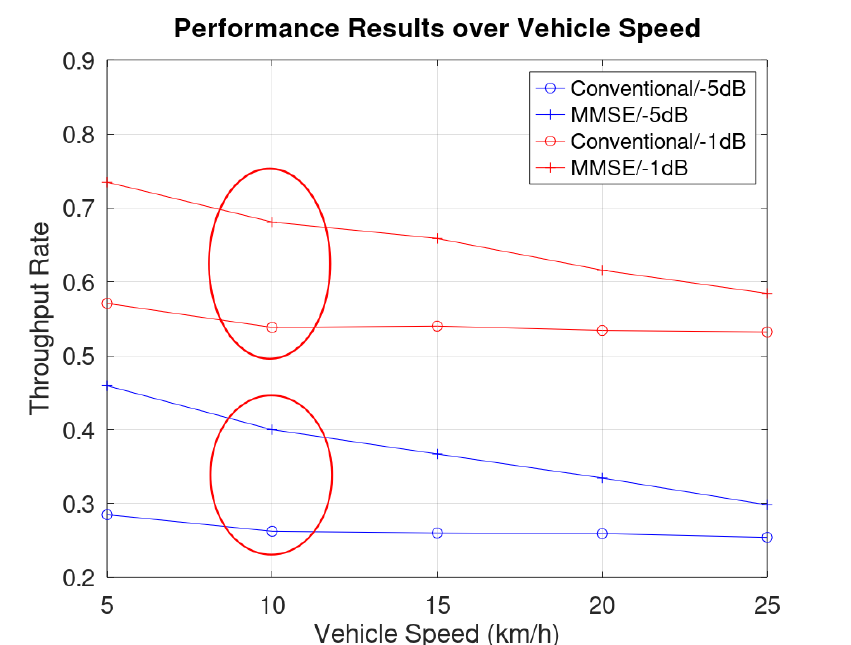
Figure 7. Throughput over vehicle speed, an equal-gain two-paths Rayleigh fading channel with 2 us delay.